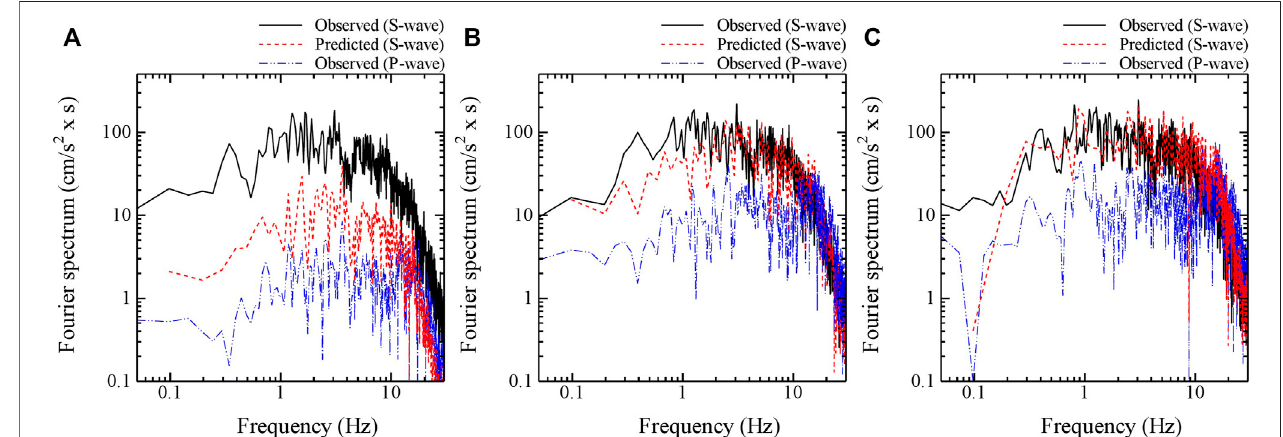
FIGURE13 | Predicted Fourier spectra ofS-wavefor time-windowsof 10,20, and 25 sduring the2011 off the Paci fi ccoast ofTohoku earthquake ( Mw 9.0) at SS station. (A) Time-window of 10 s (B) Time-window of 20 s (C) Time-window of 25 s.